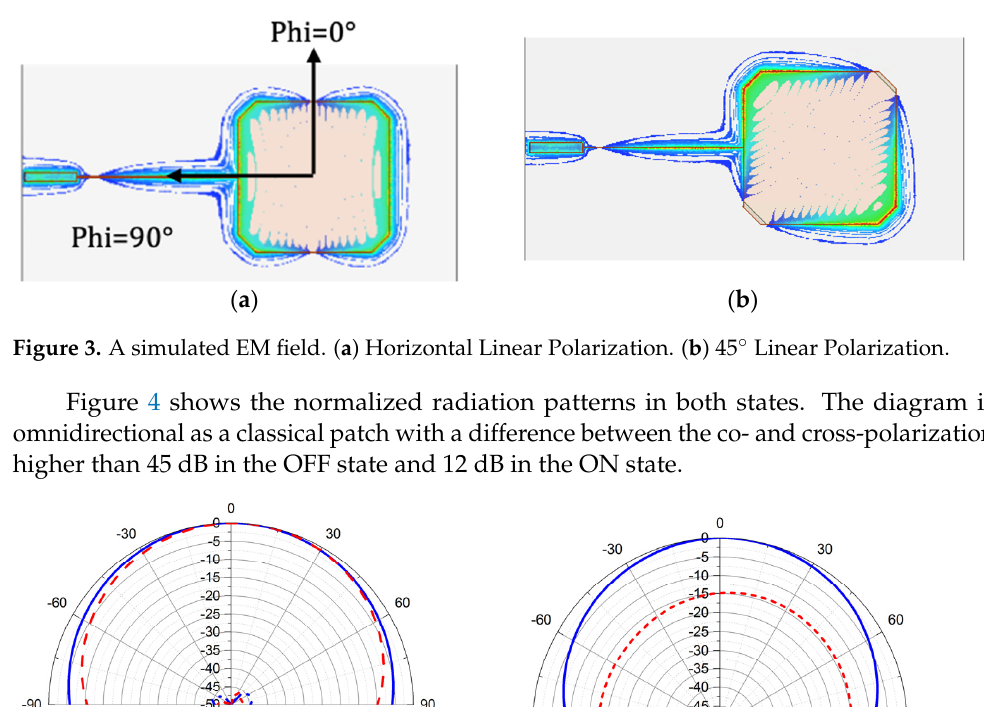
Figure 2. The simulated reflection coefficient in both states of the two linear polarization antennae.